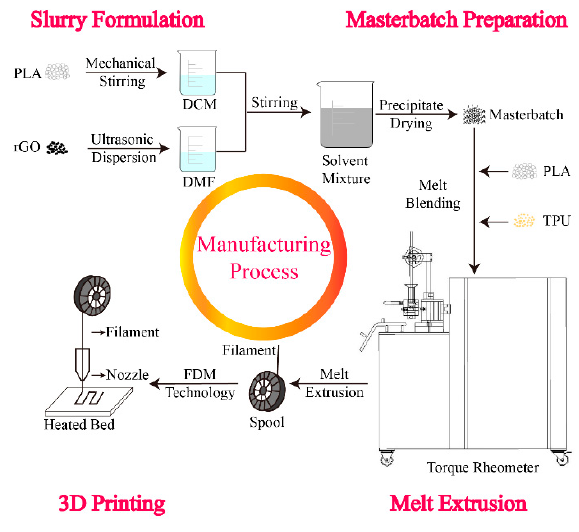
Figure 1. Main steps of the composite preparation process. Table 1. The printing parameters for the fused deposition modeling (FDM)